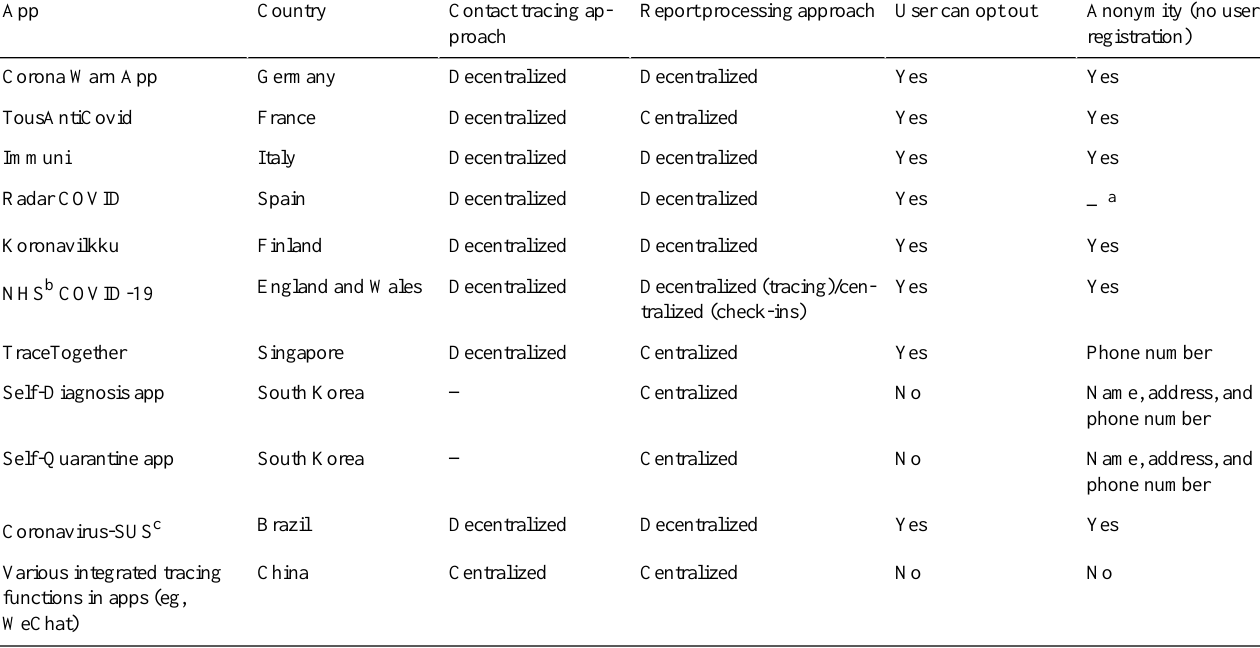
Table 3. Privacy